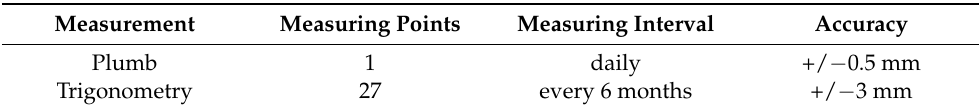
Table 2. In situ data that were used for the accuracy analysis.